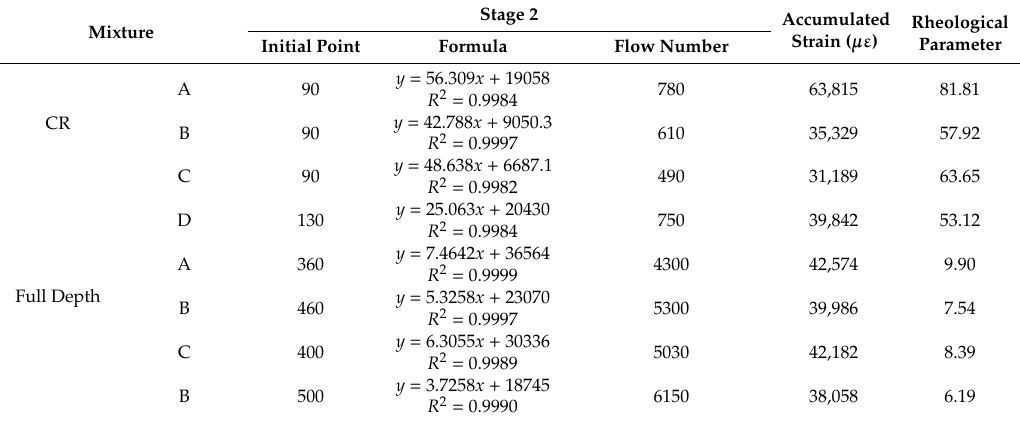
Table 5. Three-phase models of dynamic creep